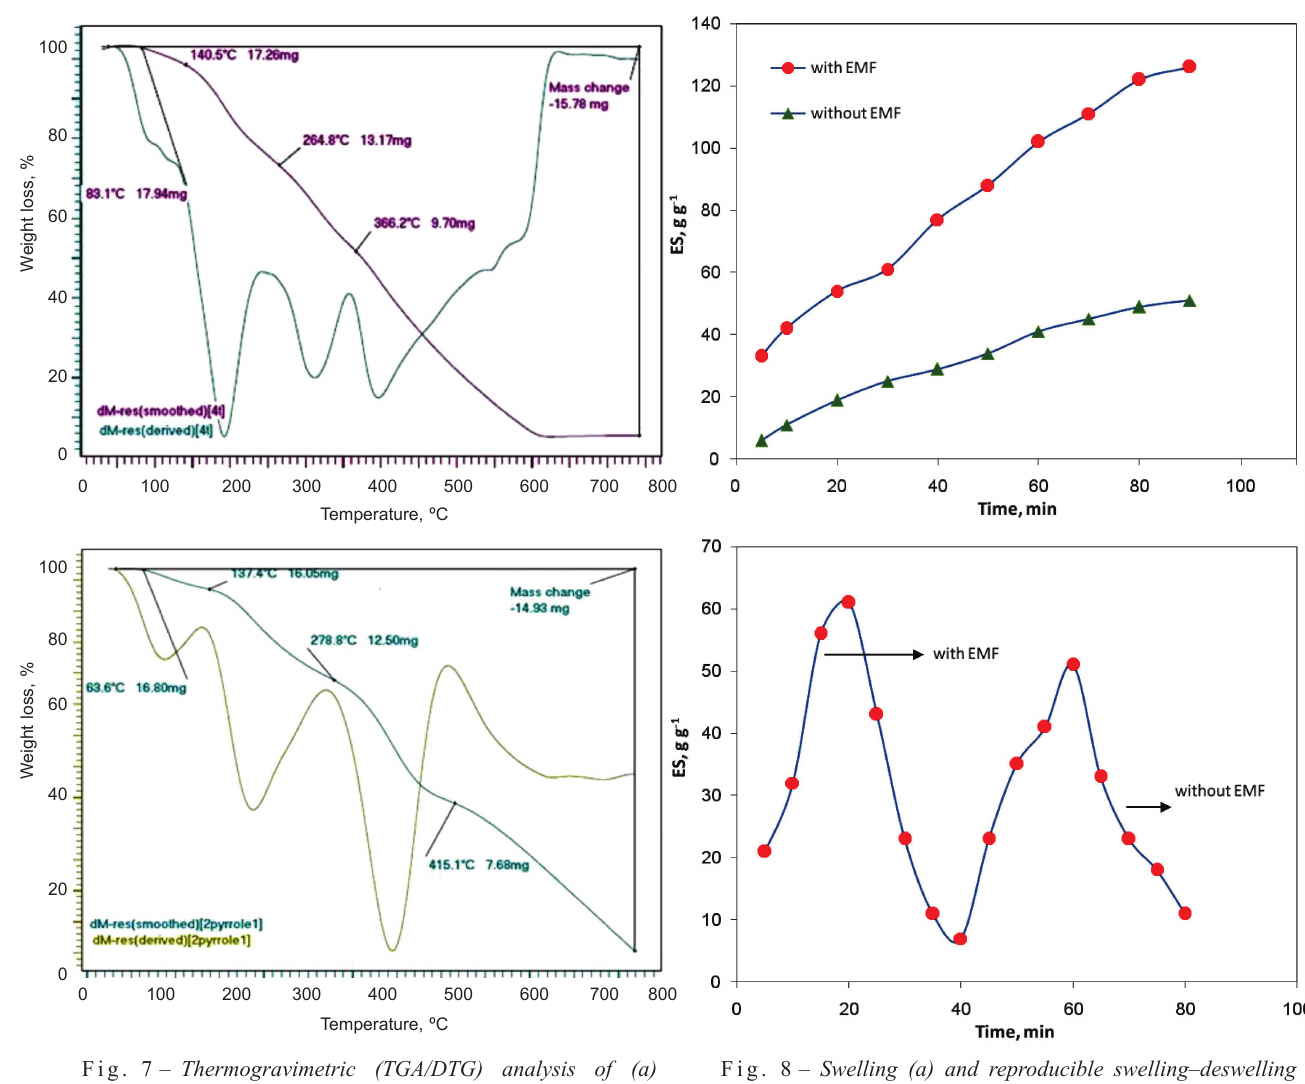
Fig. 8 – Swelling (a) and reproducible swelling–deswelling of MHN adsorbent with and without applying mag- netic field